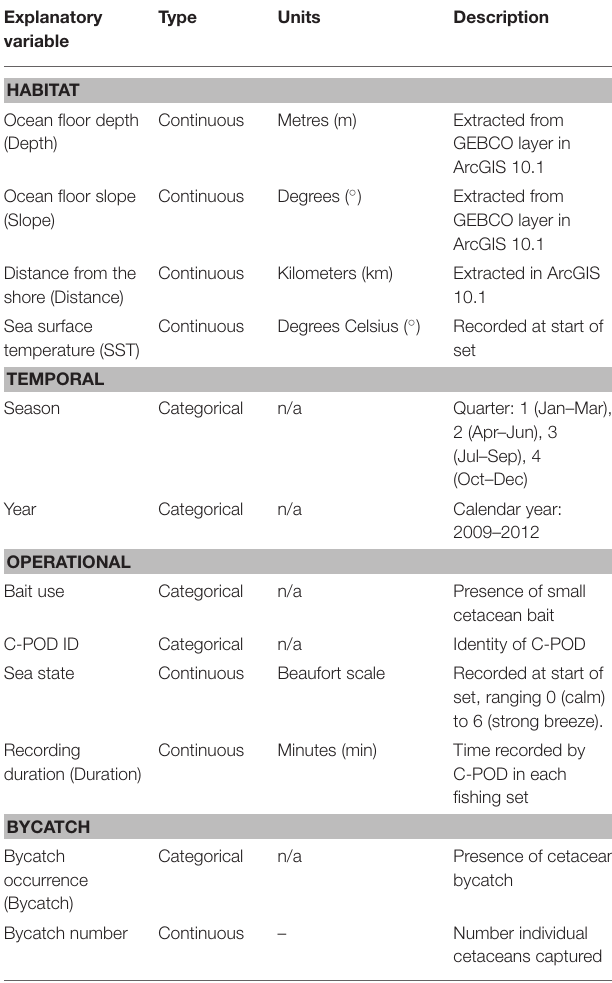
TABLE 1 | Explanatory variables included in models of Burmeister’s porpoise Phocoena spinipinnis and dolphin (unspecified delphinids) activity around fishing vessels in northern